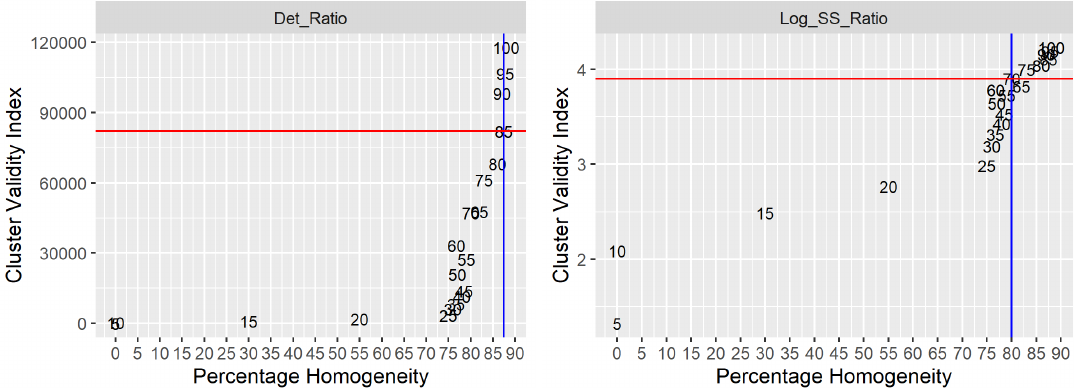
Figure 4. Illustrative example showing the performance comparison of two cluster validity indices (CVIs). Horizontal y-intercept red line represents ideal CVI. Vertical x-intercept blue line represents the value of percentage homogeneity corresponding to red line. Numericals in the plot represents the number of